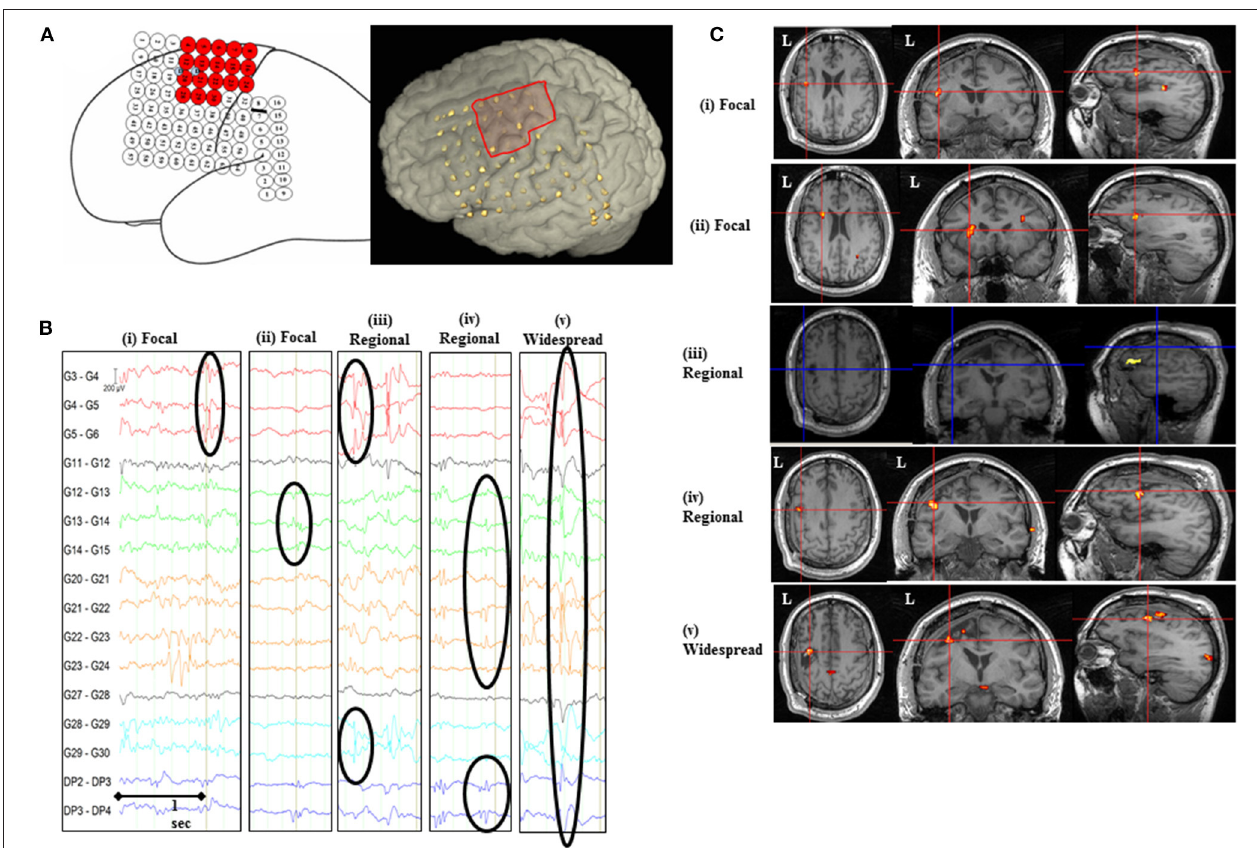
FIGURE 1 | IED-related BOLD changes for Patient #2. (A) Implantation scheme of intracranial grid, strip, and depth electrodes and the invasively defined EZ is highlighted as red-colored electrodes on the sketched diagram and red square on the 3D rendered brain. (B) Representative sample of icEEG showing different IED classes based on their topographic distribution and localization included in the general linear model. (C) SPM[F] maps ( p < 0.001) for different IED types overlaid on co-registered postsurgical T1-volume. (i) Focal IED [G4, 5 ( n = 72); Concordant plus BOLD map]: changes in left inferior/middle frontal gyrus (GM cluster, within 2cm of the surgical resection volume), left posterior temporal, and cuneus/precuneus. (ii) Focal IED [G12–15 ( n = 29); BOLD map with Some concordance]: changes in left medial occipital (GM cluster), left inferior/middle frontal gyrus (within 2cm of the surgical resection volume), left parieto-temporal, and cingulate gyrus. (iii) Regional IED [G4–6 + G12, 13 + G22–24 + G28–30 ( n = 80); Discordant BOLD map]: changes in left inferior frontal gyrus (GM cluster 2.6cm from the surgical resection volume), medial superior frontal gyrus, left temporo-occipital, and left middle frontal gyrus. (iv) Regional IED [G12–15 + G21–24 + DP2–4 ( n = 350); Concordant plus BOLD map]: changes in left middle/inferior frontal gyrus (GM cluster, within 2cm of the surgical resection volume), medial superior frontal gyrus, and supplementary motor area. (v) Widespread IED [G4–8 + G12–15 + G20–24 + G28–30 + DP2–4 ( n = 244); Concordant plus BOLD map]: changes in left middle frontal gyrus (GM cluster, within 2cm of the surgical resection volume), right middle temporal gyrus, posterior supplementary motor area, and